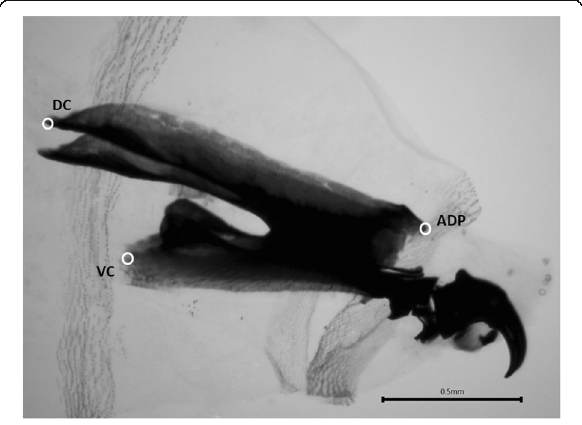
Fig. 1 Developmental landmarks of H. ligurriens based on cephalopharyngeal skeleton length (ADP-DC Anterodorsal process-dorsal cornua, ADP-VC: Anterodorsal process-ventral cornua, DC-VC Dorsal cornua-ventral cornua) (Bar = 0.5